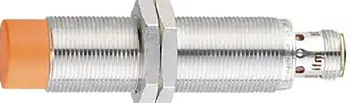
Figure 4. Physical drawing of inductive proximity switch.